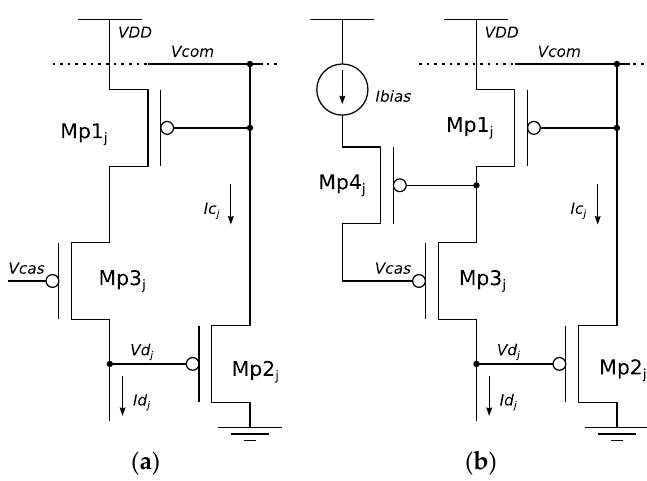
Figure 2. ( a ) Cascode WTA [5]. ( b ) Boosted-cascode WTA [7].